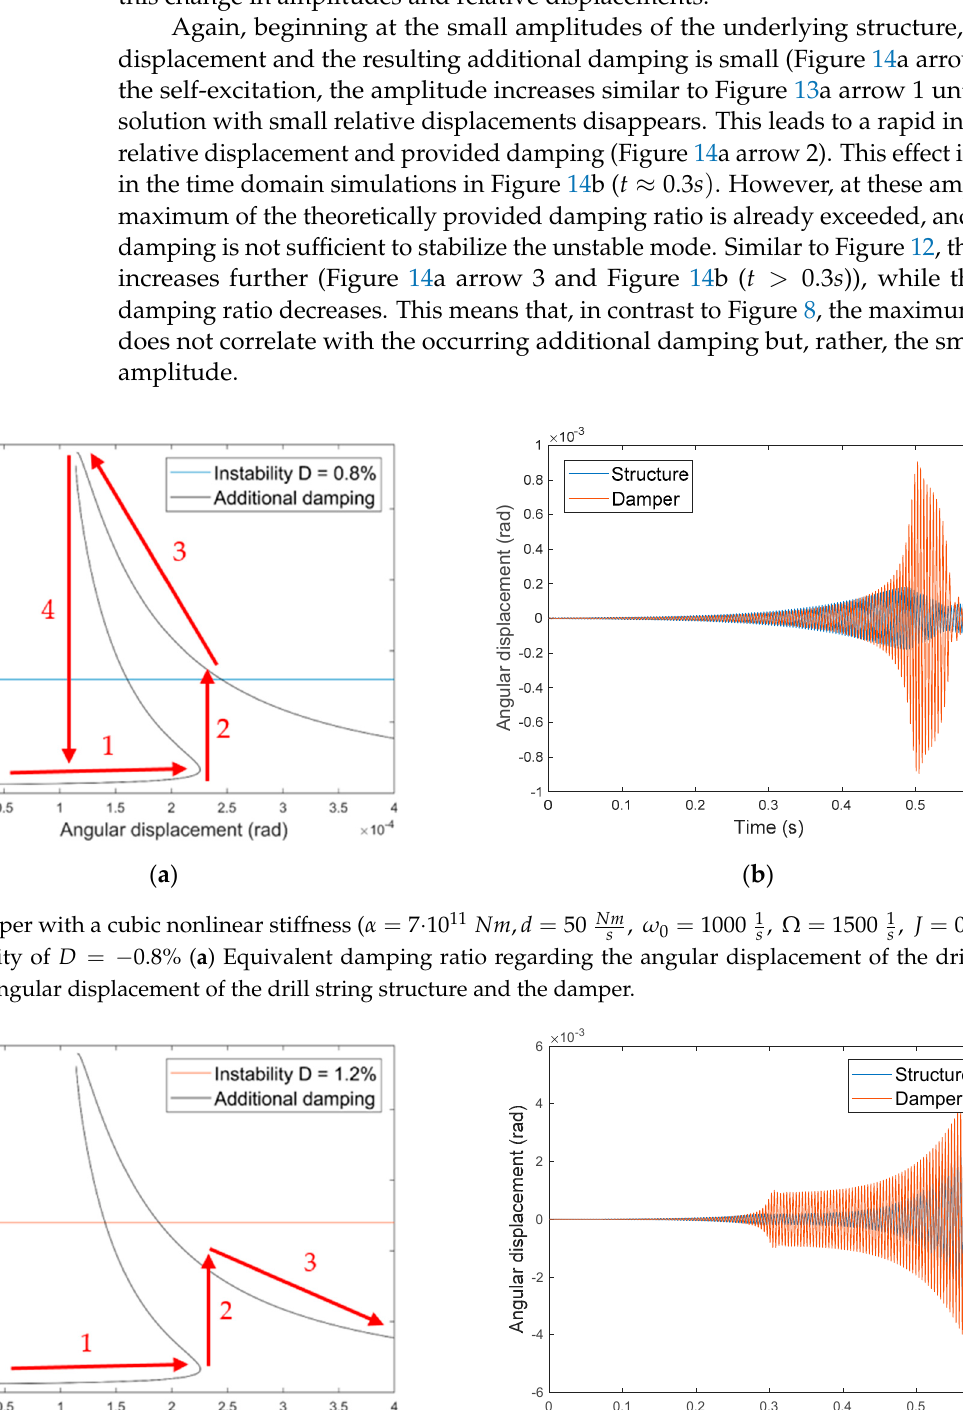
,(cid:2033) (cid:2868) = 1000 (cid:2869) , Ω = 1500 (cid:2869) , (cid:1836) = 0.2 (cid:1863)(cid:1859)(cid:1865) (cid:2870) ) , ω 0 = 1000 1 , Ω = 1500 1 , J = 0.2 kgm 2 ) and s s s (cid:3046) (cid:3046) (cid:3046)